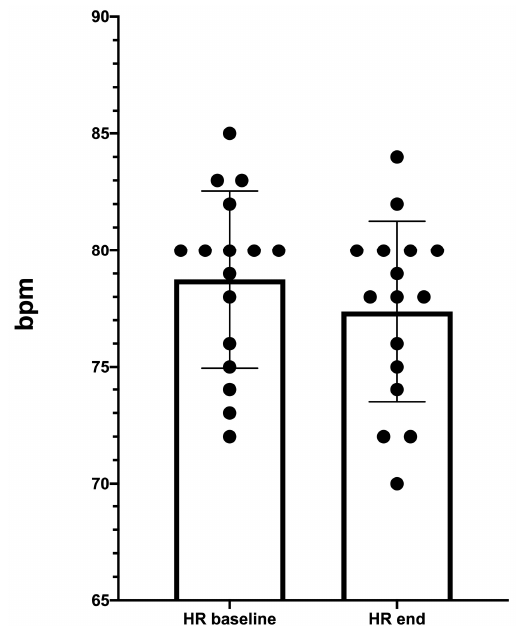
Figure 5. Heart rate (HR) at rest decreasing after the five exercise sessions. HR baseline = T0; HR end = 2 days after the end of the program.